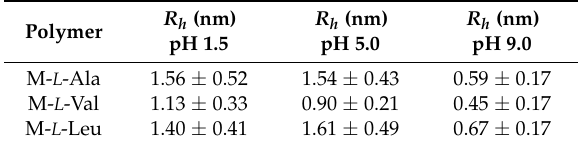
Table 3. pH Dependence of PAAC hydrodynamic radius in water a .